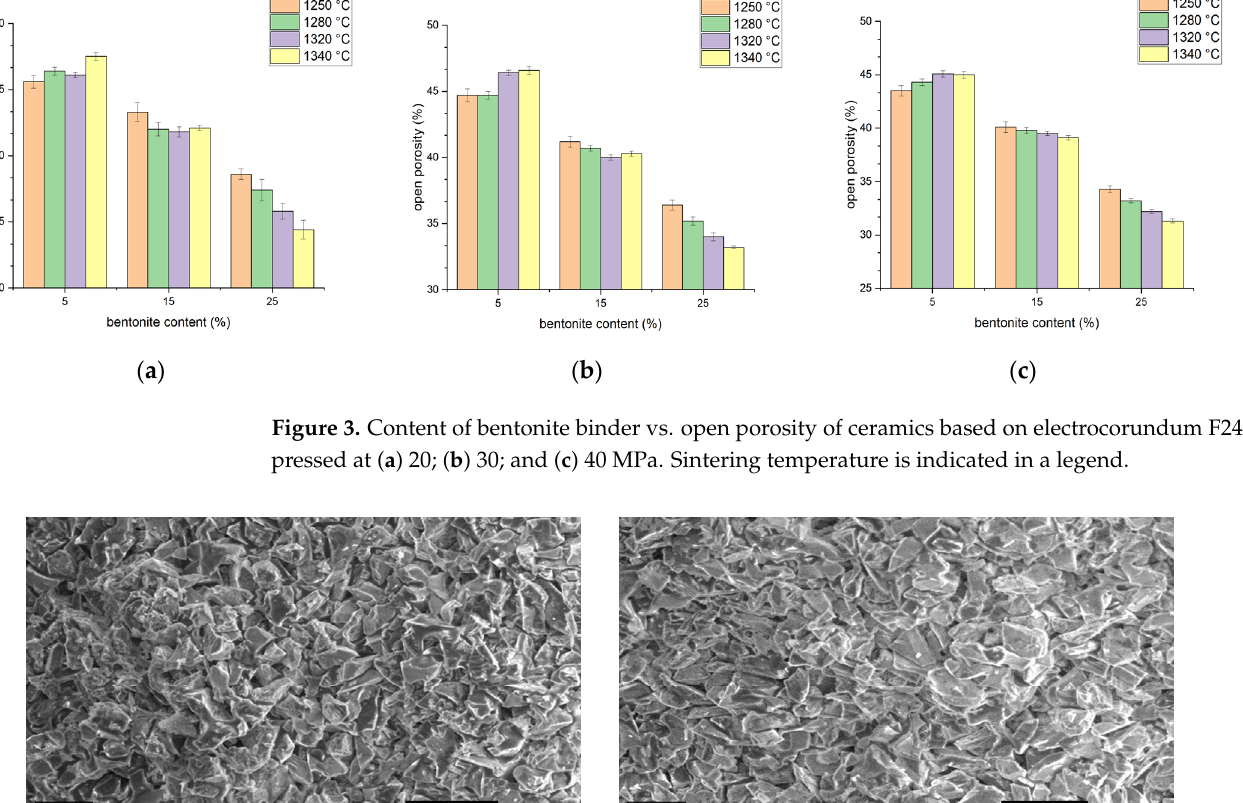
Figure 3. Content of bentonite binder vs. open porosity of ceramics based on electrocorundum F240 pressed at ( a ) 20; ( b ) 30; and ( c ) 40 MPa. Sintering temperature is indicated in a legend.